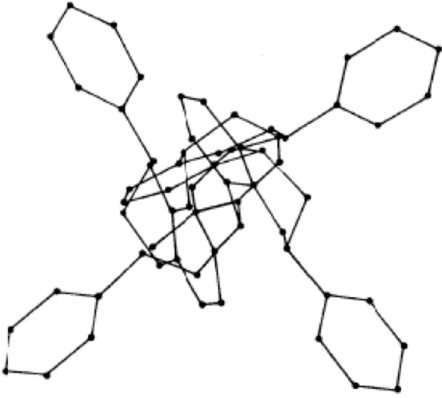
Figure 5. Tridimensional structure of a tetraflavonoid 4,8-linked.